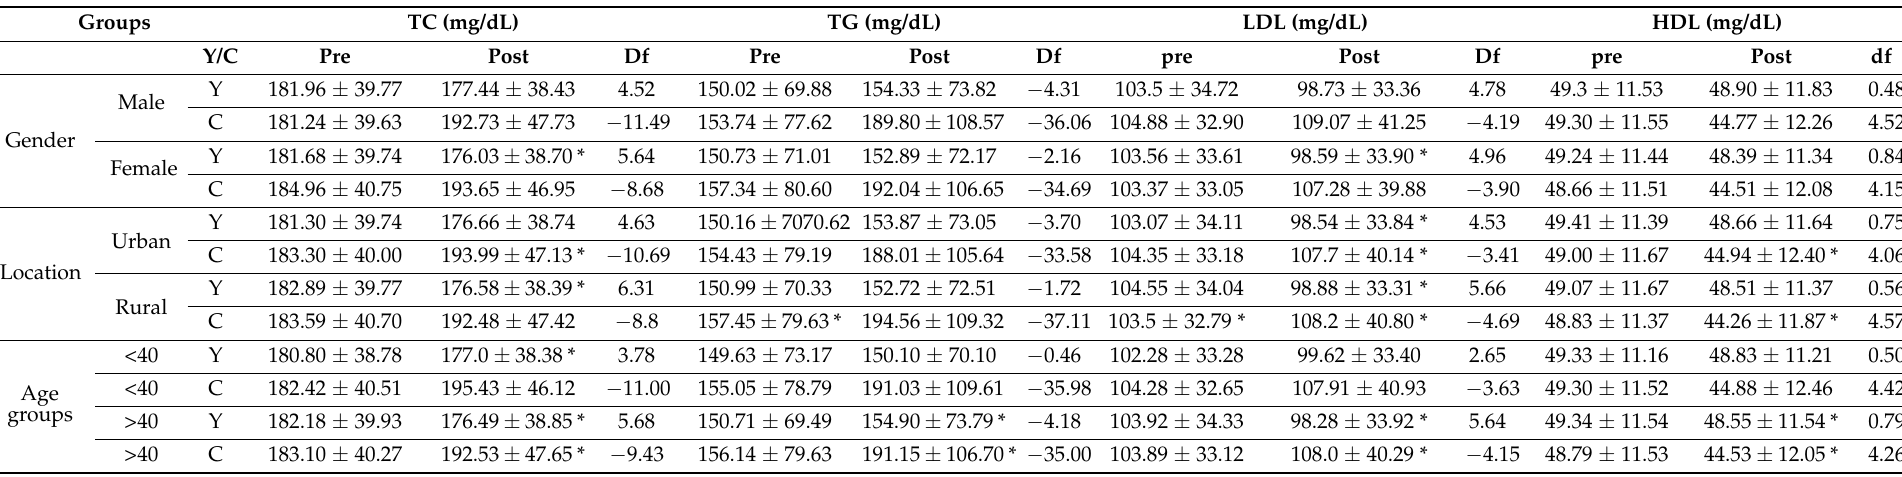
Table 4. Changes in lipid profile in two groups after three months in gender, area (rural/urban), and age